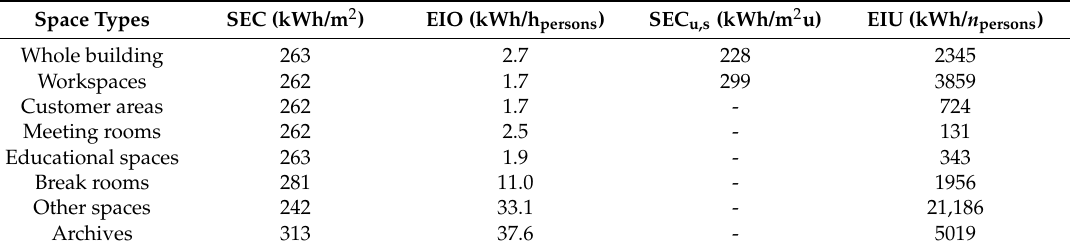
Table 8. Values of energy efficiency indicators for the various spaces after the renovation.